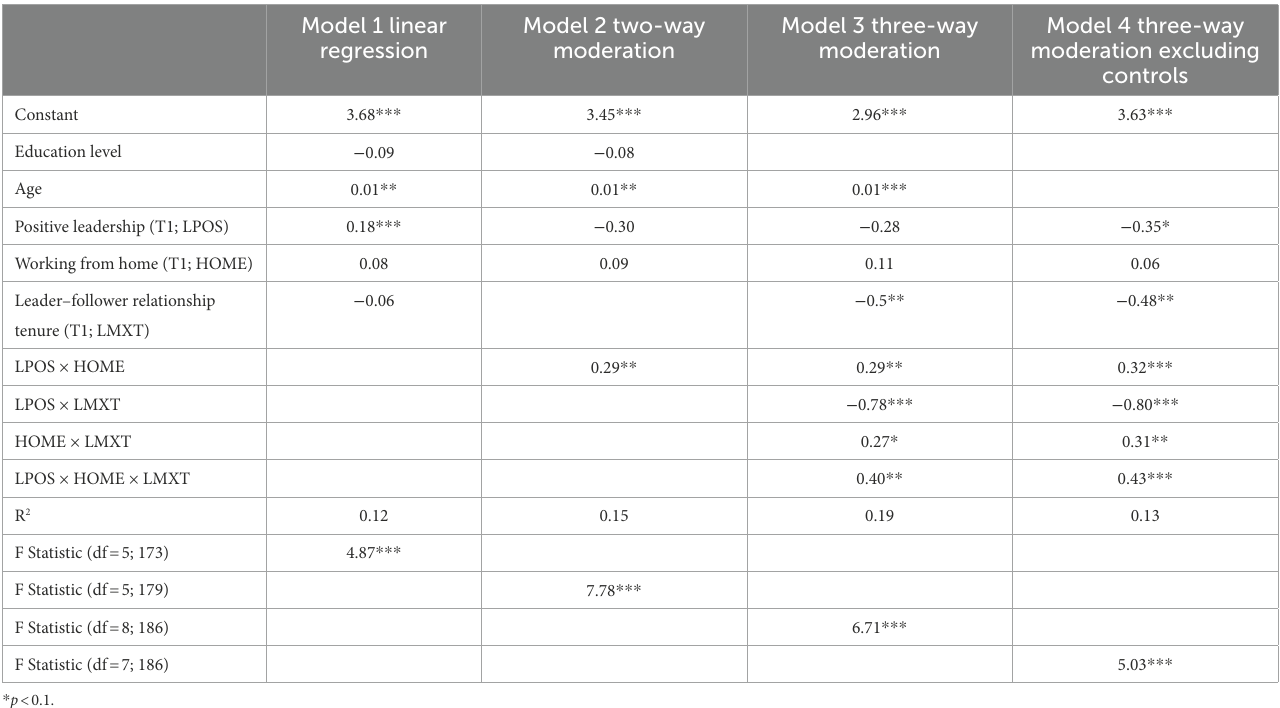
TABLE 2 Results of multiple regression analyses predicting vigor.